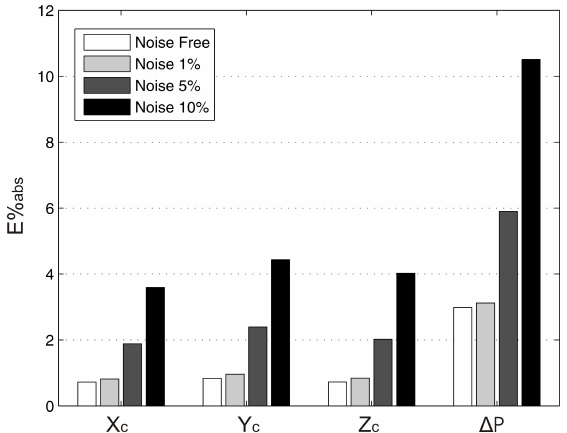
Fig. 5. Mean percent error E % abs for each source parameter using noisy deformation patterns at the inputs of the ANN inverse model.